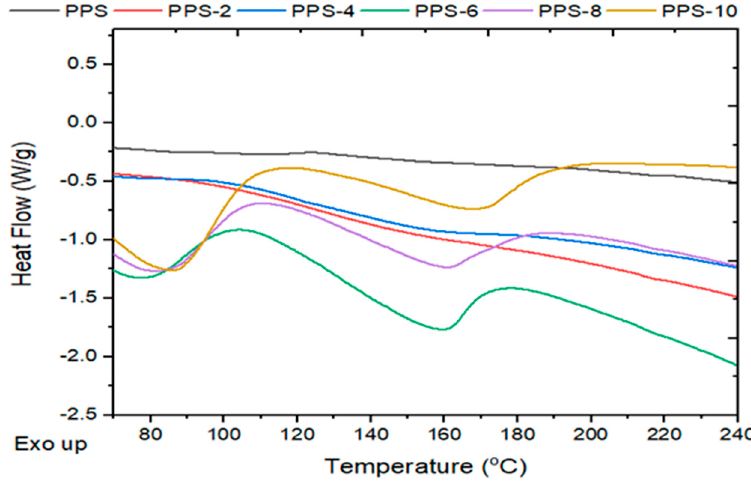
Polymers 2023 , 15 , x FOR PEER REVIEW